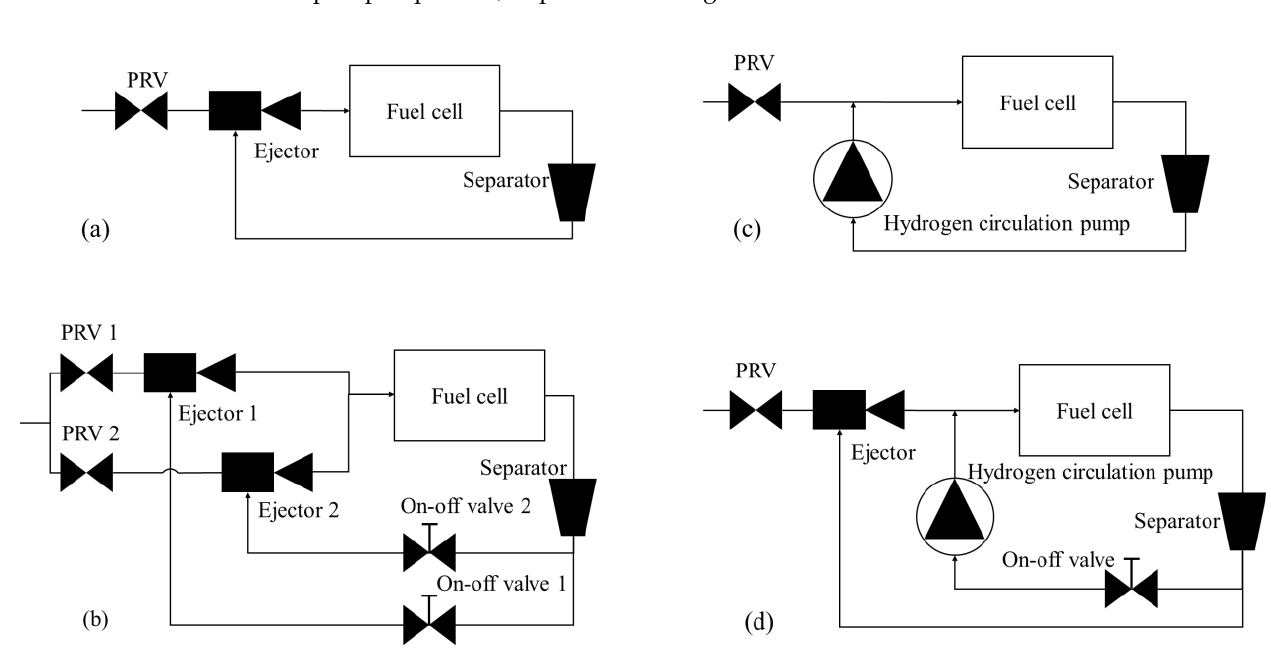
Figure 11. Schemes of the hydrogen circulation system: ( a ) single ejector; ( b ) double ejector; ( c ) hydrogen circulation pump; ( d ) ejector and circulation pump in parallel.